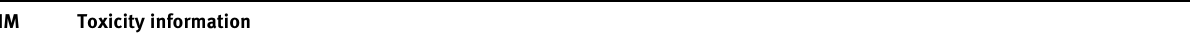
Table  : Toxicity of heavy metals of environmental and health